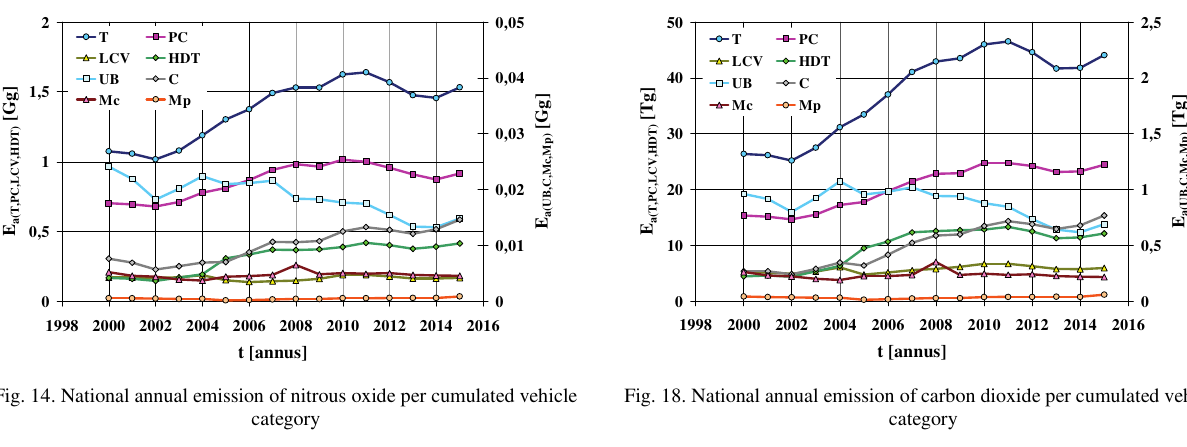
Fig. 13. National annual emission of nitrogen oxides per cumulated vehicle Fig. 17. National annual emission of particulate matter from the exhaust category system of internal combustion engines per cumulated vehicle category